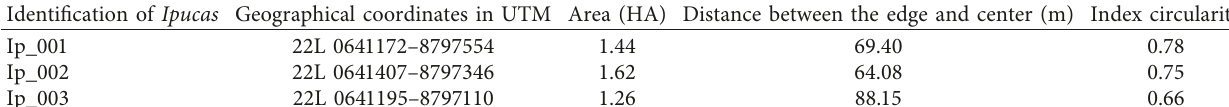
Table 1: Geographic location and characteristics of the Ipucas studied.